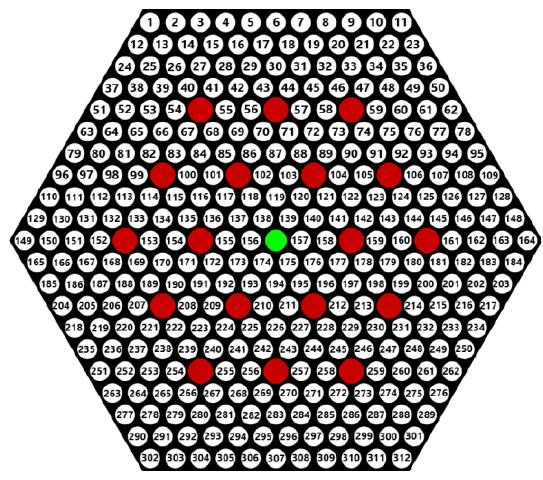
Figure 4. Pin numbering of measured FAs #4 and